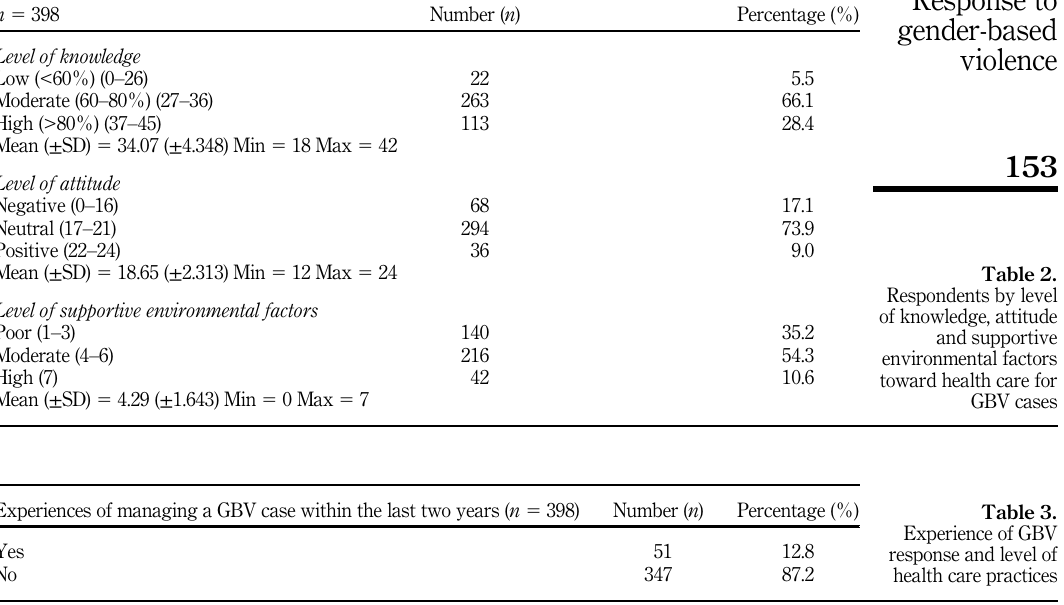
Table 4. Details of